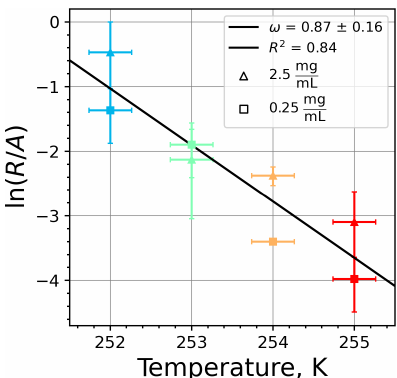
Figure A7. Freezing rate of illite NX normalized to surface area as a function of temperature for experiments at the M-WT with particle con- centrations of 2.5 and 0.25gL − 1 (plotted by triangles and rectangles, respectively). Freezing rates were calculated from the time dependence of the liquid ratio of illite NX presented in Fig. 6 in Diehl et al. (2014).